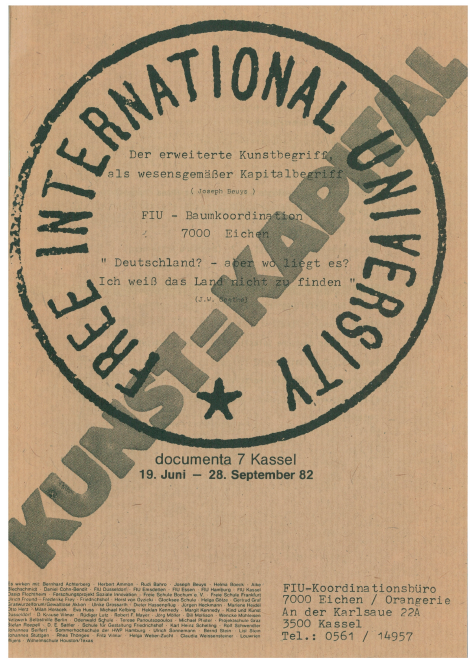
Figure 1. FIU placard at Documenta 7 in Kassel with the equivalence Art = Capital [38].